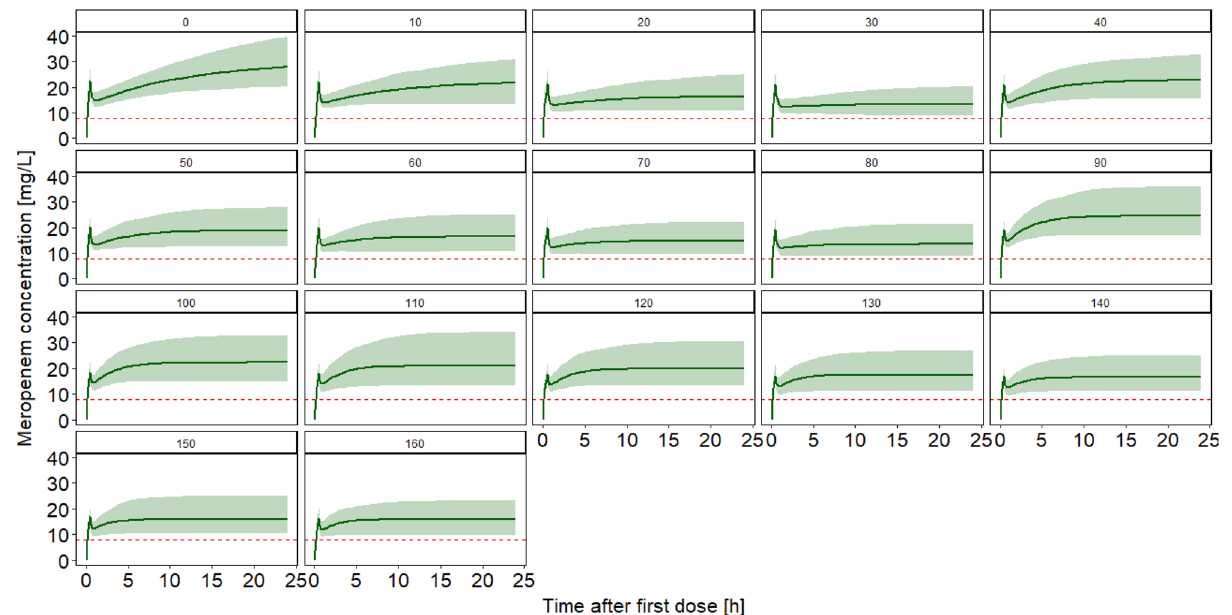
Figure 1. Predicted plasma concentration–time profile in patients with varying kidney function and a loading dose of 0.33 g. Patients with varying renal function (creatinine clearance according to Cockcroft and Gault 9 0–160 mL/min, step-size: 10 mL/min, respective numbers in the plots indicate the individual creatinine clearance), albumin was fixed to 2.8 g/dL, body weight was fixed to 70 kg. Daily doses of 1.5 g were administered for patients with creatinine clearances of 0–30 mL/min, 3 g for creatinine clearances 40–80 mL/min and 6 g for patients with creatinine clearances 90–160 mL/min. Line: median concentration, Shaded area: 90% prediction interval, Horizontal dotted line: 4 × S/I breakpoint of Pseudomonas aeruginosa according to 12 .